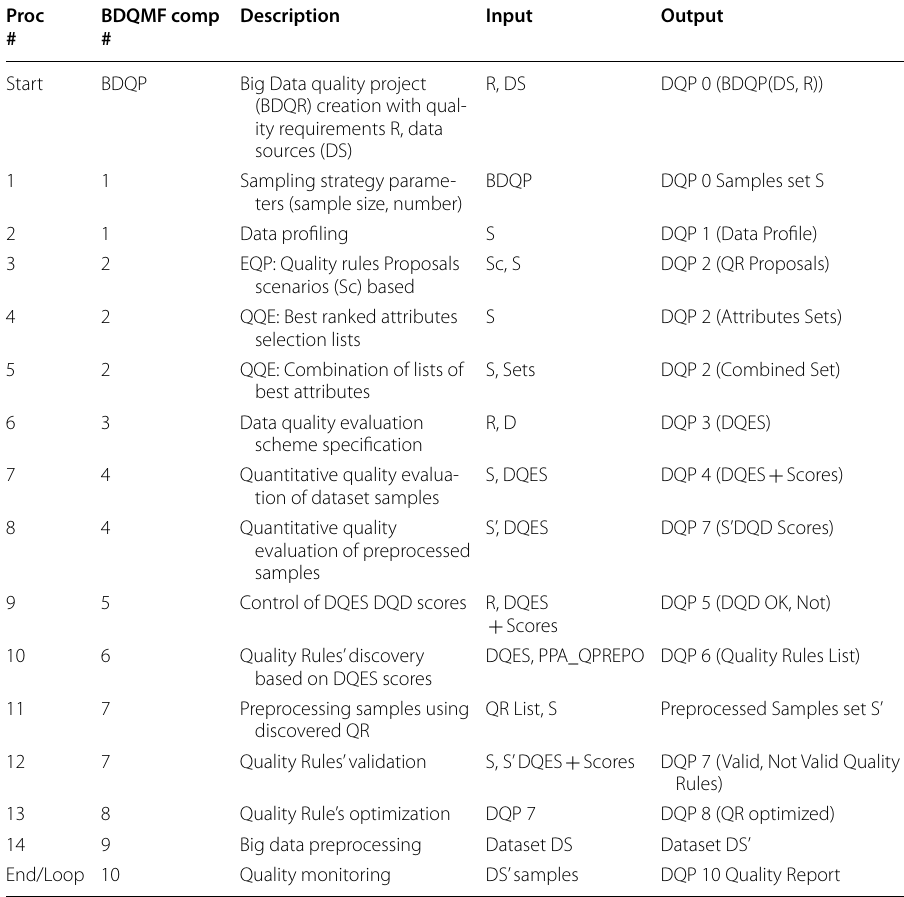
Table 9 Data quality profile levels